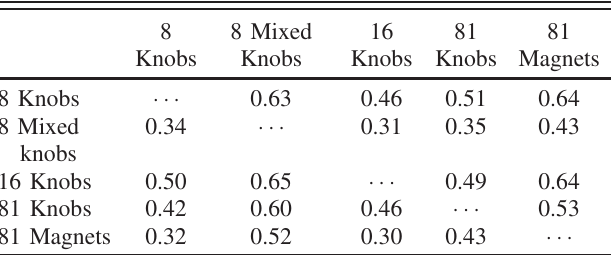
TABLE III. Comparison of genetic algorithms with different genes. The fraction of trials (out of 179) where the individuals found by the genetic algorithm running with the genes listed on the left comprise the majority of the joint nondominated front when its final population is combined with the final population of the algorithm running with the genes listed above. Higher numbers indicate better performance by the genes to the left and poorer performance by the genes above. In general, the use of conjugate directions significantly improves the convergence of the genetic